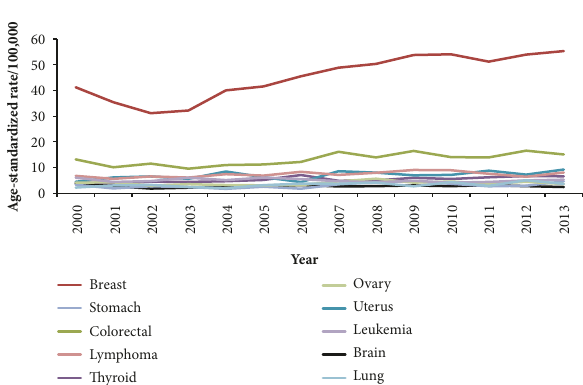
Figure1:Thetrendintheage-standardizedincidenceratesofcancer for males and females in Jordan, 2000-2013.